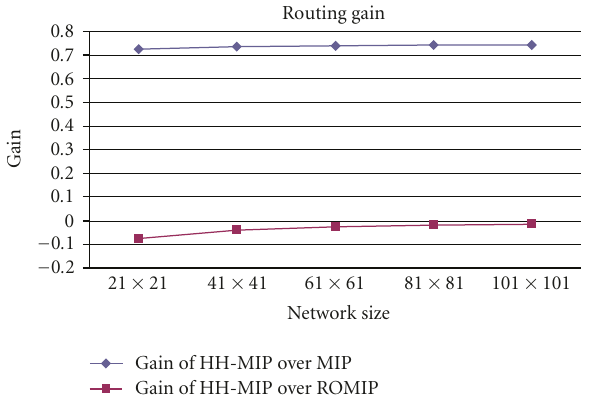
Figure 12: Comparison of routing gains. Figure 13: Comparison of hando ff latency gains.